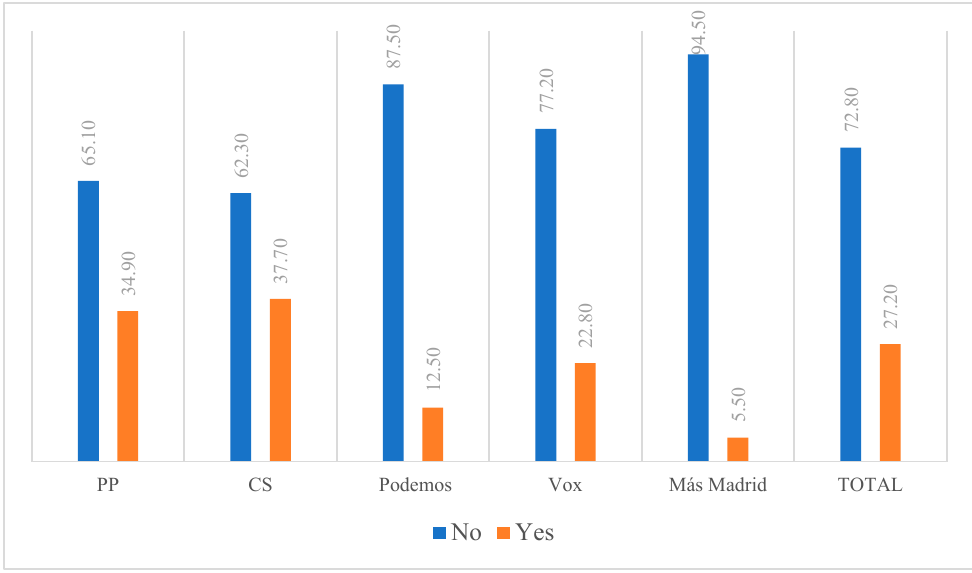
Figure 1. Presence of criticism in Telegram messages from political parties (% within the user). Source: Self-made.